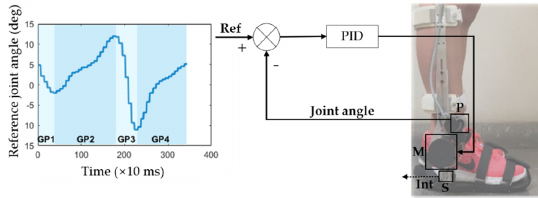
Figure 1. Diagram of the ankle–foot exoskeleton’s trajectory tracking control, where Ref is the reference joint angle (segmented in four gait phases GP1-4), Int is human-robot interaction torque, M is the actuator, P is the potentiometer, and S is the strain gauge.